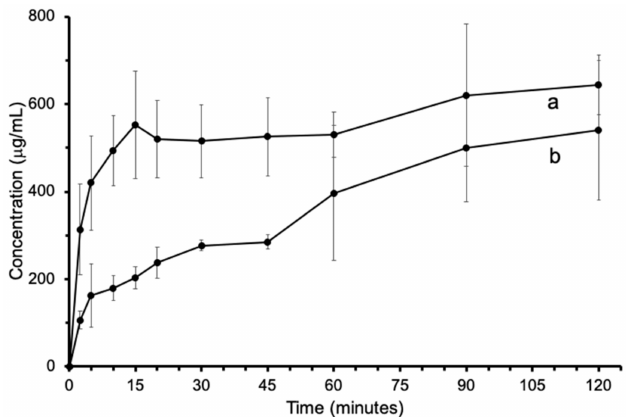
Figure 9. Tax-ET ( a ) and Tax-EA ( b ) dissolution profile at 37 ◦ C in pH 4.5 solution and 100 rpm agitation. The scale bars correspond to the standard deviation values; experiments were performed in